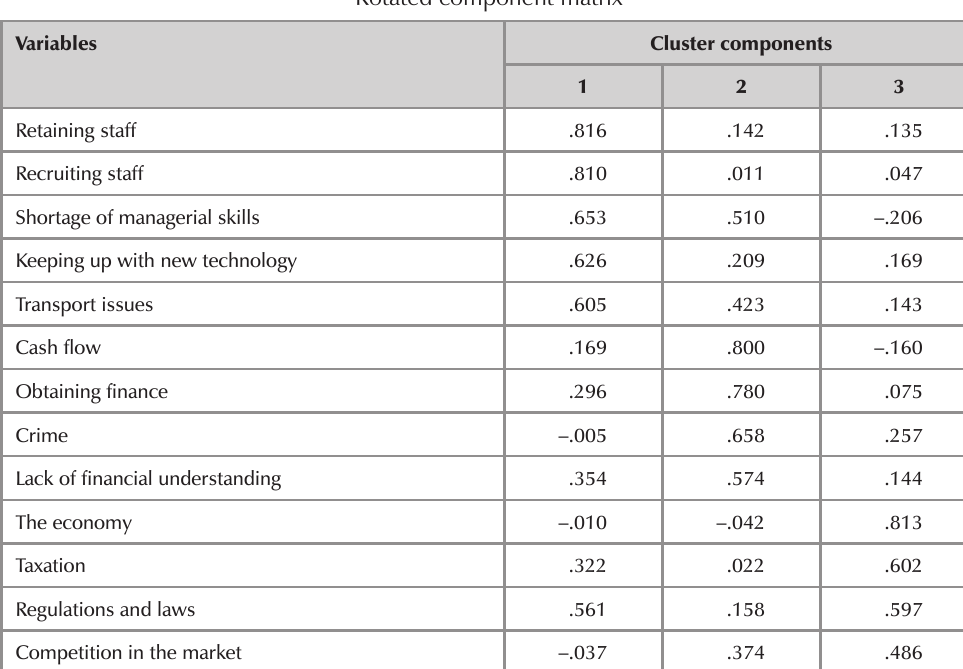
Rotated component